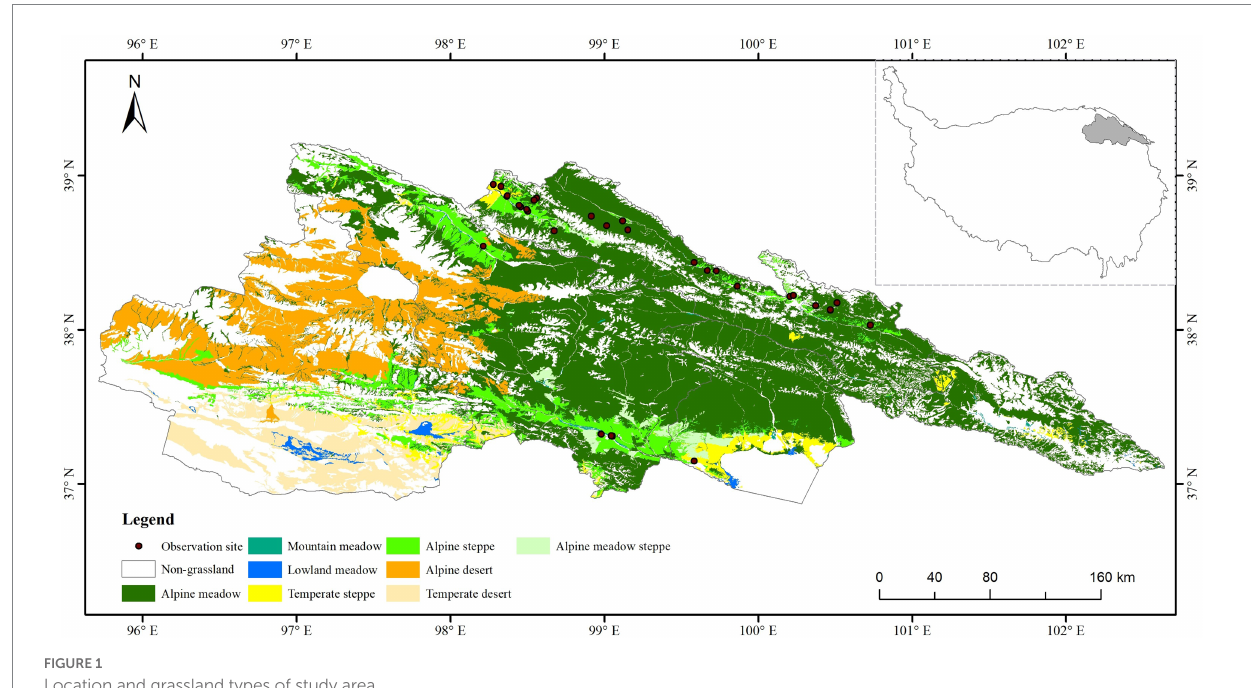
FIGURE 1 Location and grassland types of study